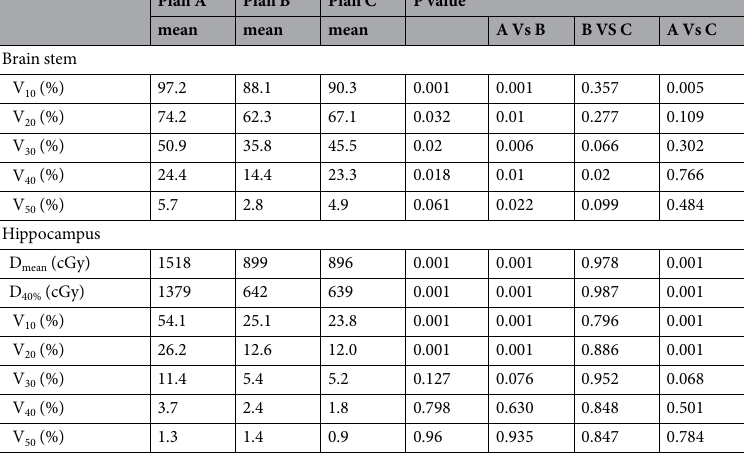
Table 3. The doses to brain stem and hippocampus. (Plan A: C-VMAT, Plan B: HS-VMAT, PlanC: HS-dMLC).